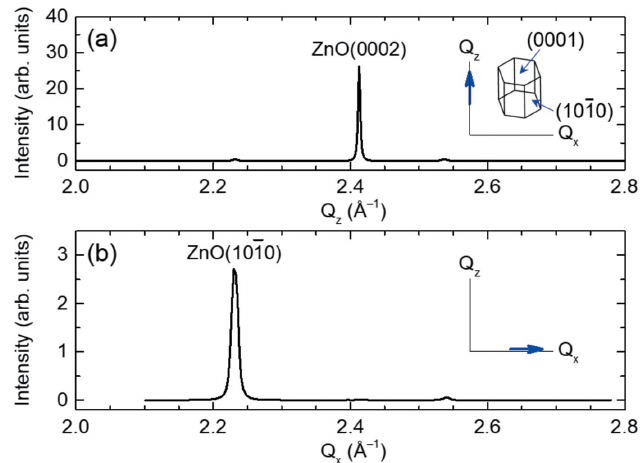
Figure 3 ( a ) Powder XRD and ( b ) GIXS profiles of ZnO nanorods along the out- of-plane Q z and in-plane Q x directions, respectively. The GIXS profile is measured at an incident angle of 0.2 (cid:2) . The scan directions in Q x – Q z reciprocal space are illustrated in the in-set. The (0001) and ð 10 (cid:2) 110 Þ atomic planes of hexagonal wurtzite ZnO are aligned with the Q z and Q x directions, respectively.